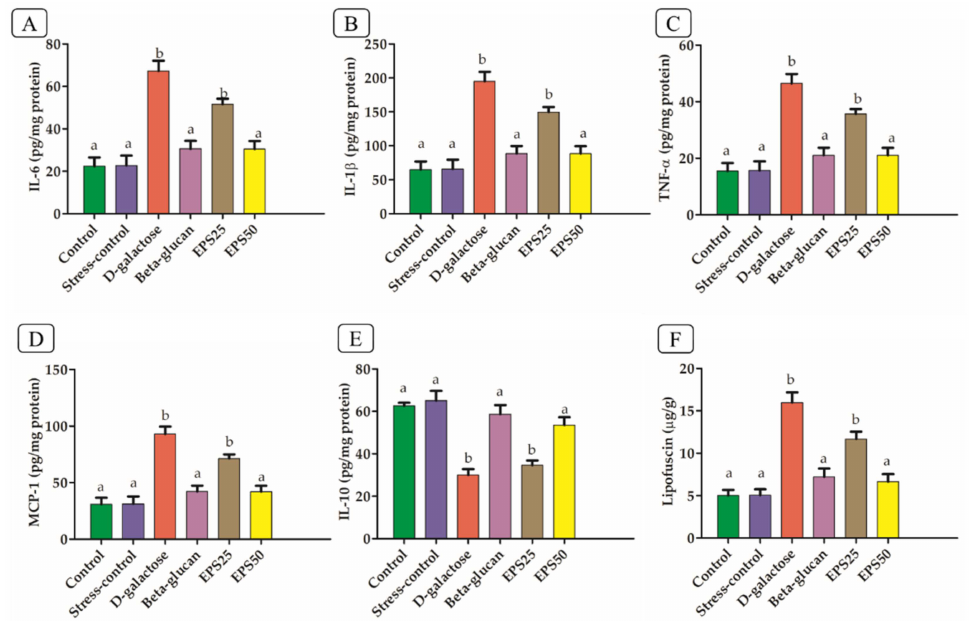
Figure 3. Effects of EPSRam12 on inflammatory markers and Lipofuscin content in the brain in D-galactose-induced mice. ( A ) IL-6, ( B ) IL-1 β , ( C ) TNF- α , ( D ) MCP-1, ( E ) IL-10, and ( F ) Lipofuscin. Data are presented as mean ± SEM. Data were analyzed using One-way ANOVA with Bonferroni post-test. Values with dissimilar superscript alphabets (a–b) indicate significant differences ( p < 0.05) among the treatment